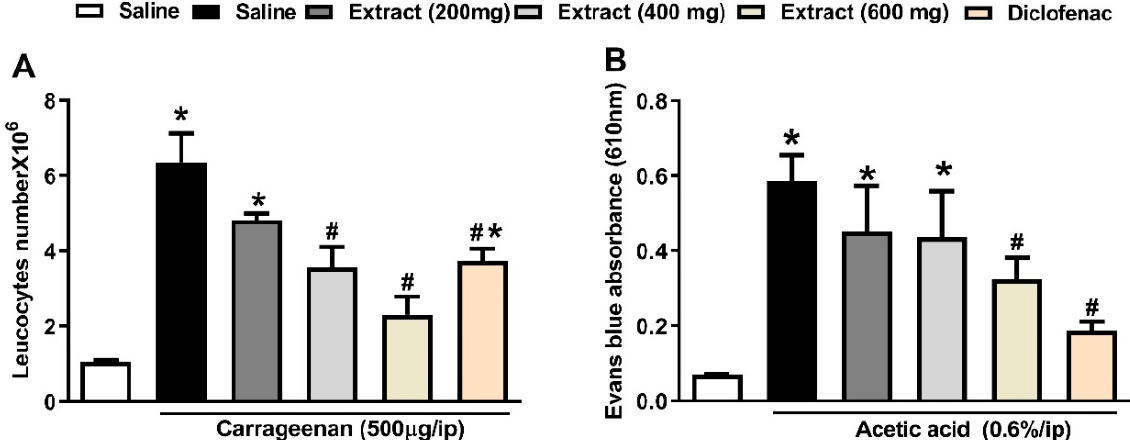
Figure 3. ( A ) Results from P. perfoliatus extract on carrageenan-induced leukocyte migration into the peritoneal cavity in mice (total number × 10 6 ). Animals received the extract (200, 400 and 600 mg/kg, p.o.), diclofenac (20 mg/kg, p.o.) or vehicle 1 h before carrageenan injection (500 µg, i.p.). ( B ) Results from P. perfoliatus extract on acetic acid-induced vascular permeability. Mice received different treatments 1 h before acetic acid (0.6%, i.p.) and Evans blue dye injections. The amount of dye extravasation into the abdominal cavity was quantified and used as an indicator of inflammation degree. The results are shown as means ± SEM ( n = 5–6). * p < 0.05 compared to saline group. # p < 0.05 compared to control (carrageenan or acetic acid only treated group).